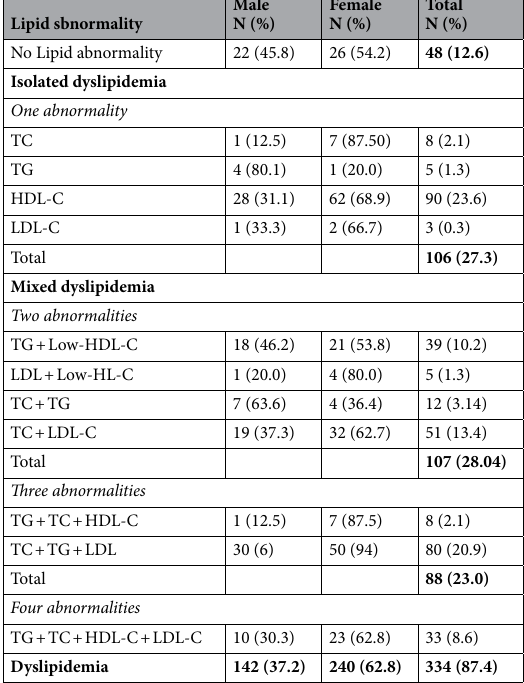
Table 4. Mixed dyslipidemia. Significant values are in bold. TG triacylglycerol, TC total cholesterol, HDL-C high-density lipoprotein cholesterol, LDL-C low-density lipoprotein